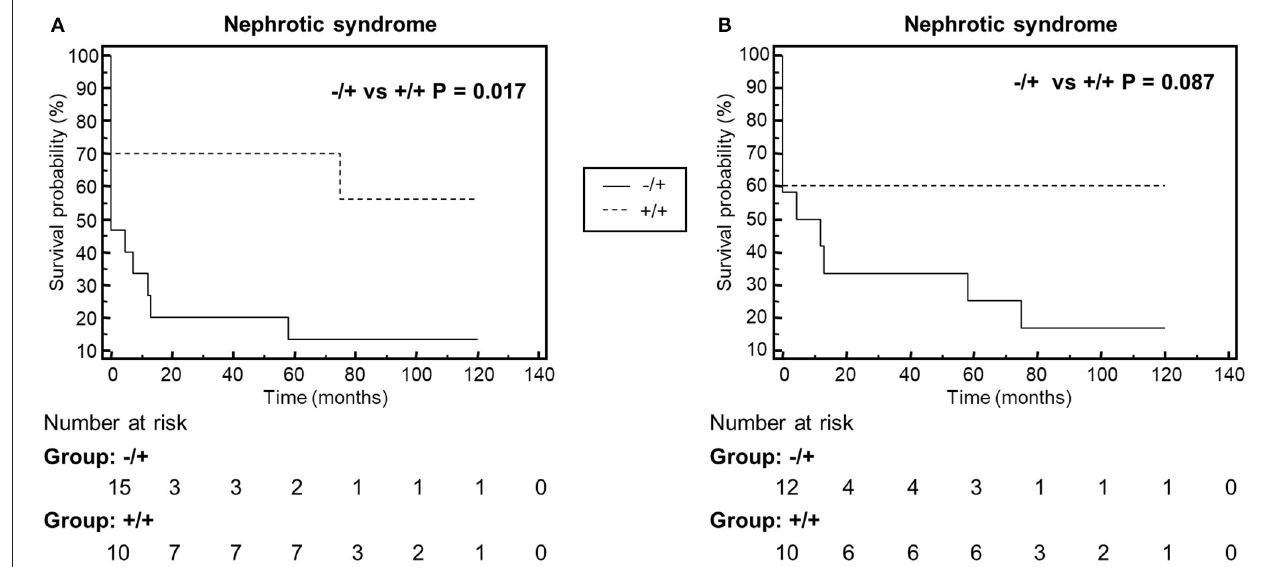
FIGURE 8 | Kaplan-Meyer analysis of the event nephrotic syndrome during the disease course. The analysis shows that patients with properdin dependent C3 convertase stabilizing activity against spontaneous ( A , Group − / + : sCSA − /sPCSA + ) or FH-mediated ( B , Group − / + : FH − CSA − /FH − PCSA + ) decay, have higher risk to manifest nephrotic syndrome than patients with properdin-independent activities ( A , Group + / + : sCSA + /sPCSA + ; B , Group + / + : FH + CSA + /FH + PCSA +